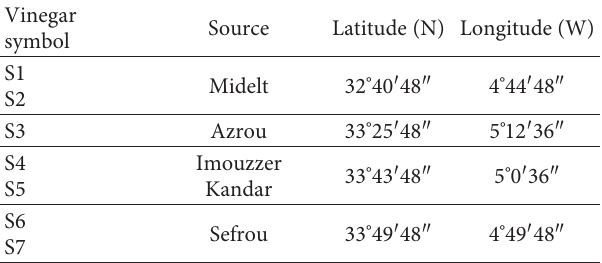
Table 1: Geographical locations of apple vinegar samples